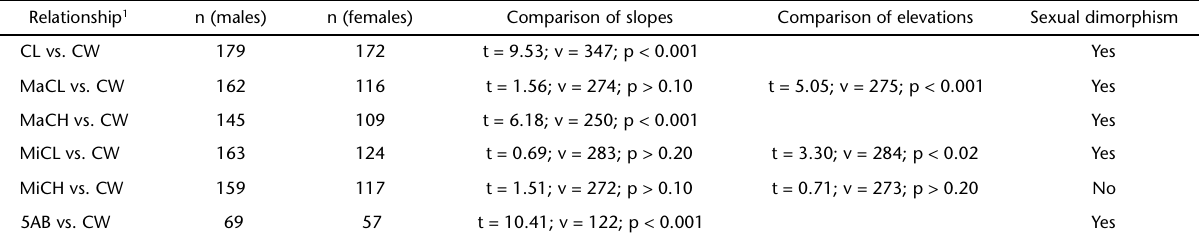
Table III. Trichodactylus fluviatilis . Student’s t comparisons of linear regression parameters between males and females, to test for sexual dimorphism. v, degrees of freedom. Relationship 1 Comparison of slopes Comparison of elevations Sexual